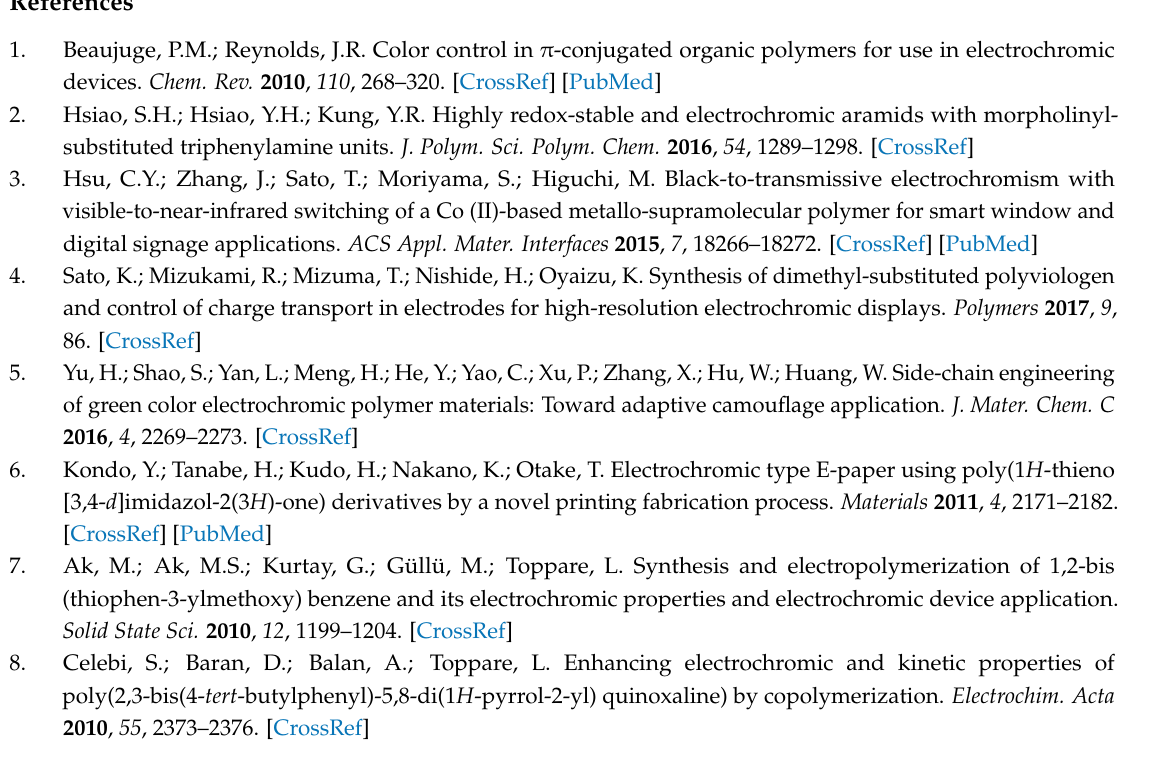
Figure S1: 1 H NMR spectrum and 13 C NMR spectrum of 2-dodecyl-4,7-di(5-bromo-thiophen-2-yl)-2 H -benzo[ d ] [1,2,3]triazol in CDCl 3 : (a) 1 H NMR, solvent peak at δ = 7.26 ppm was marked by “x”; (b) 13 C NMR, solvent peak at δ = 77.01 ppm was marked by “X”. Figure S2. 1 H NMR spectra of the polymers in CDCl 3 : (a) P(TBT-TBTh); (b) P(TBT-F-TBTh). Solvent and tetramethylsilane peaks were marked by “x”, “y”